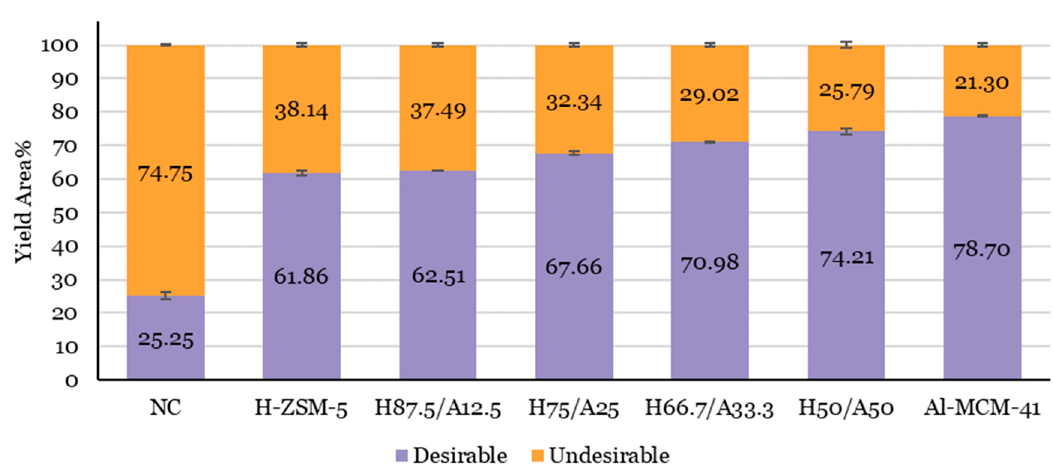
Figure 5. The chemical composition of AF for lignocellulose biomass catalytic pyrolysis with different proportions of H-ZSM-5 and Al-MCM-41. A non-catalytic case is included as a reference case. Yield Area (%) Desirable = area hydrocarbons (aliphatic, BTX, naphthalene, styrene, other aromatics) % + area phenols % + area furans % + area alcohols %. Yield Area (%) Undesirable = area PAHs % + area ethers % + area aldehydes % + area ketones % + area acids and esters % + area carboxylic % + area amines and amides % + area others (unidentified compounds) %. Data was taken from Table 3.